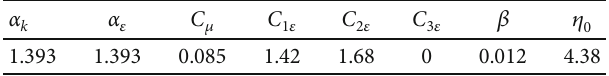
Figure 1: Flow fi eld grid model. Table 1: Default constants for turbulence